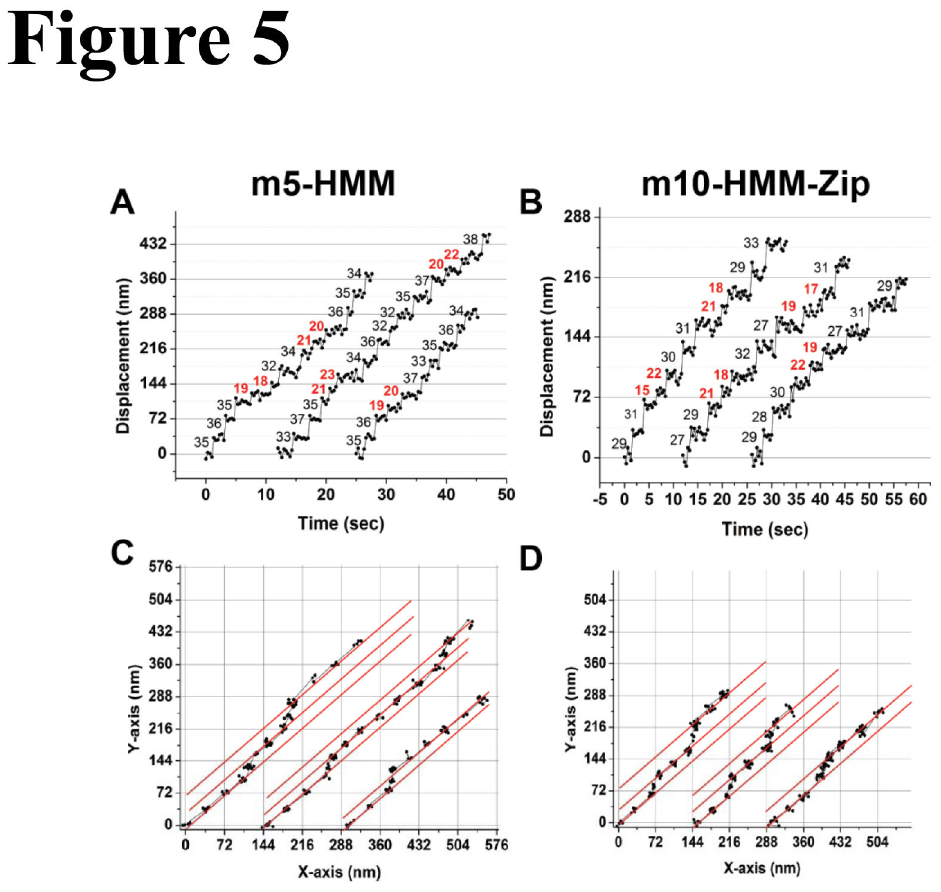
Figure 5. Stepping traces of double-head labeled m5-HMM and double-head labeled m10-HMM-Zip on F-actin rafts with fascin. Stepping traces of m5-HMM (A) and m10-HMM-Zip (B) over time. (C) XY-plots of the stepping positions of m5-HMM data shown above in panel (A). (D) XY plots of the stepping positions of m10-HMM-Zip data shown above in panel (B). Small step sizes (red numbers in A and B) represent the side-steps from one actin filament to the other on the F-actin rafts. Red solid lines in C and D indicate 45 degree angles with respect to the X-axis along each actin filament in the rafts. doi: